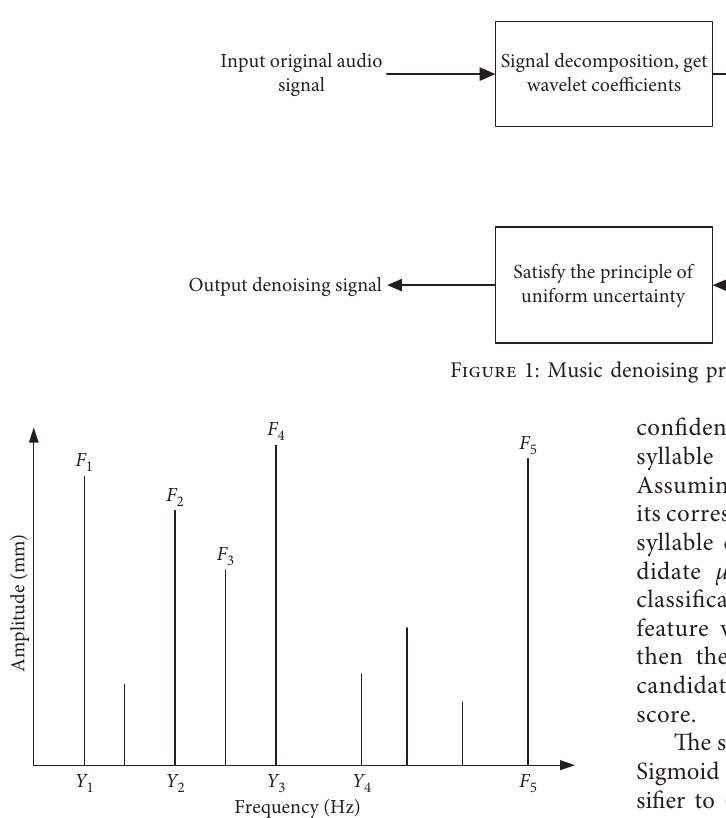
Figure 2: The frequency-amplitude diagram of the note com- parison